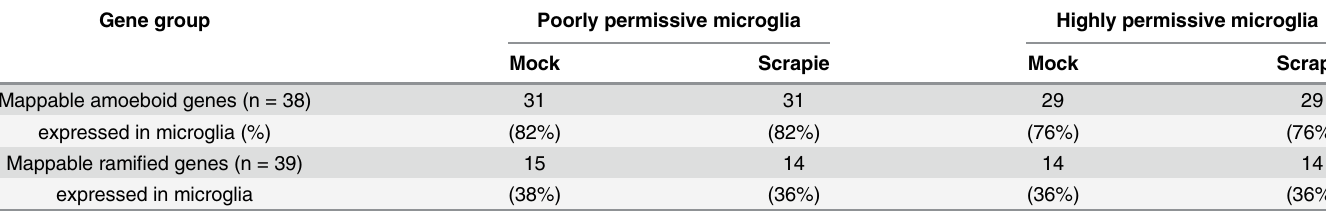
Table 7. Enriched genes of rat amoeboid microglia present in ovine microglia. Gene group Poorly permissive microglia Highly permissive microglia Mock Scrapie Mock Scrapie Mappable amoeboid genes (n = 38) 31 29 expressed in microglia (%) Mappable rami fi ed genes (n = 39) expressed in